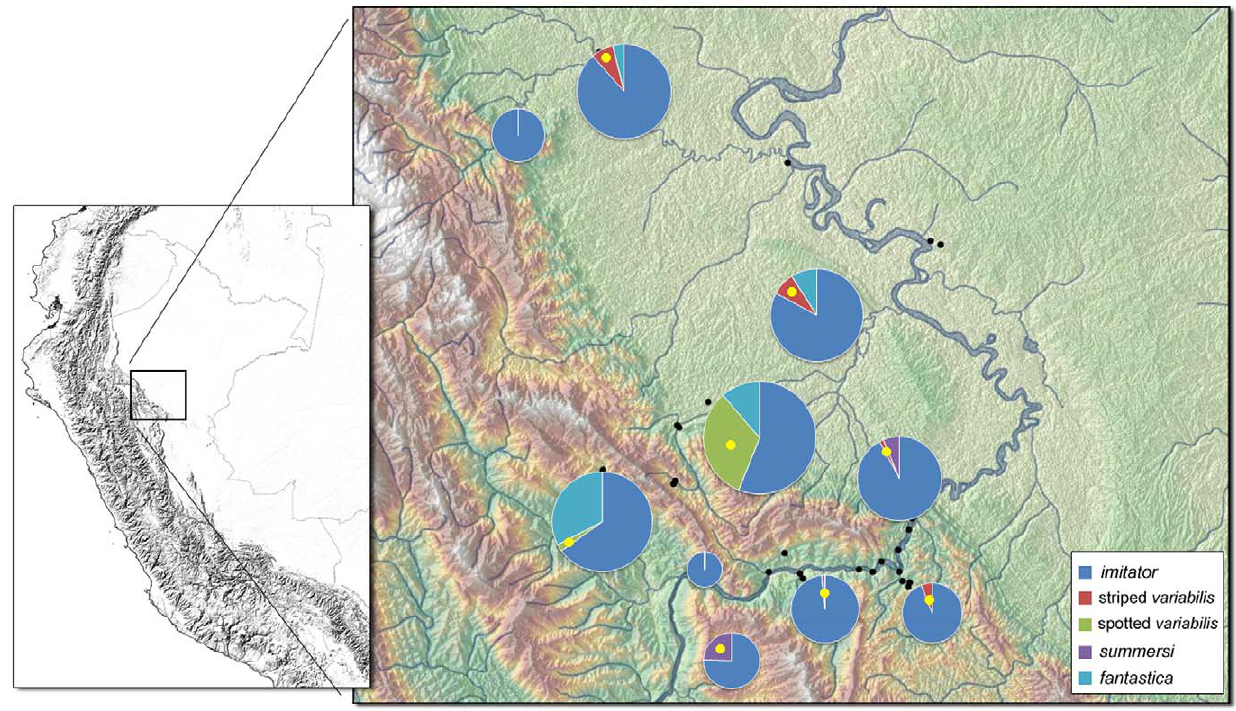
Figure 5. Relative abundance of R.imitator vs. other sympatric species of Ranitomeya . The yellow dot indicates which species is the putative model in that site. These data were obtained from sampling trips over the years 2004–2010 based primarily on field notes, photographic records, and mark-recapture surveys made by current and former lab members. Overall, 791 frogs were recorded, 671 of which were R. imitator . doi:10.1371/journal.pone.0055443.g005 PLOS ONE |